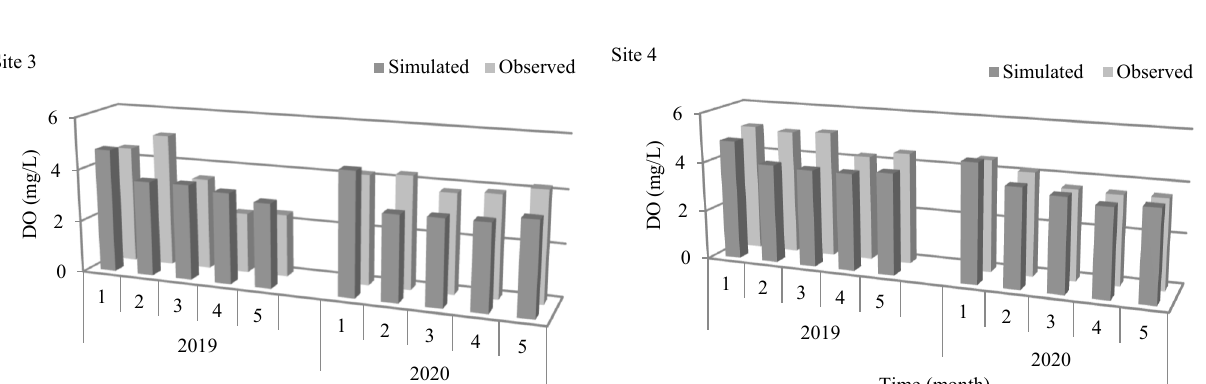
Figure A2. Calibrated and verified results of DO concentration at the four locations within the study area for the years 2019 and 2020.